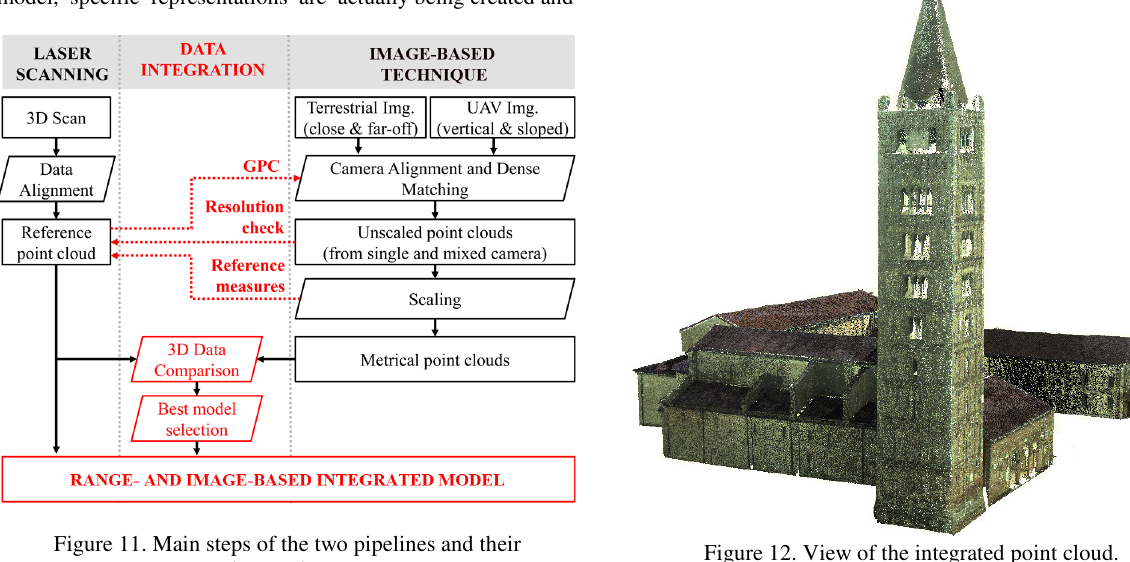
Figure 12. View of the integrated point